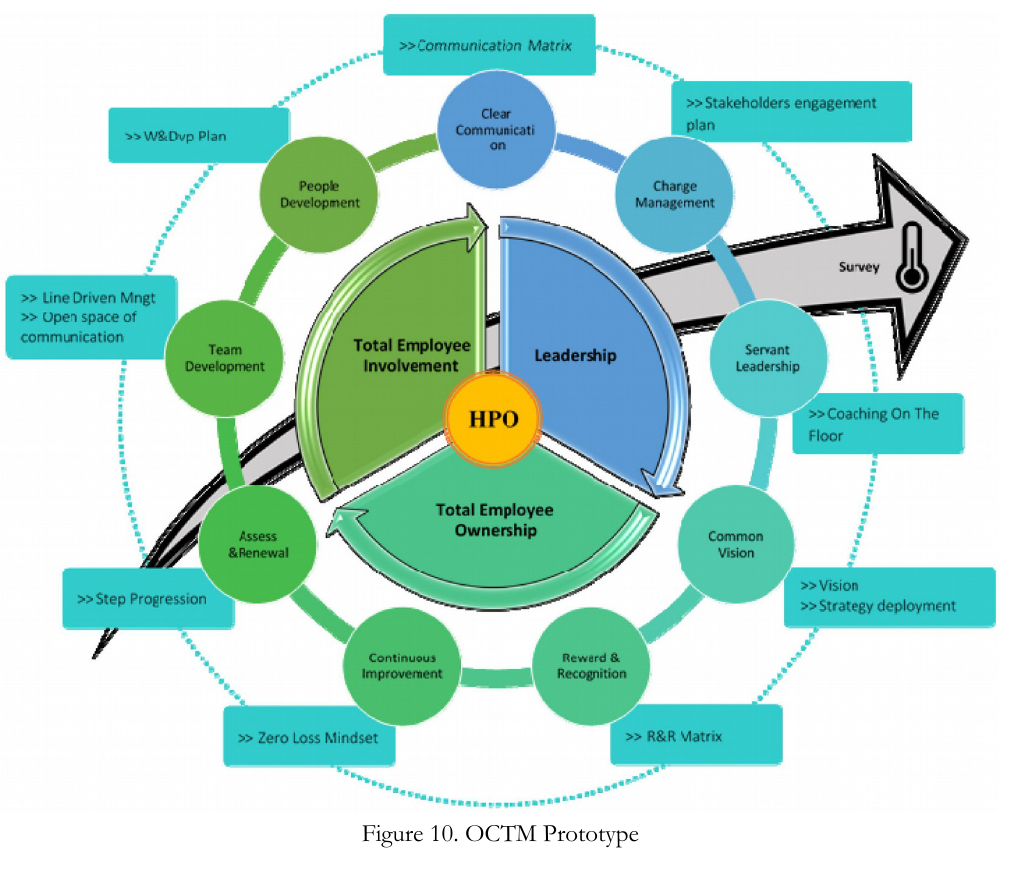
Figure 10. OCTM Prototype